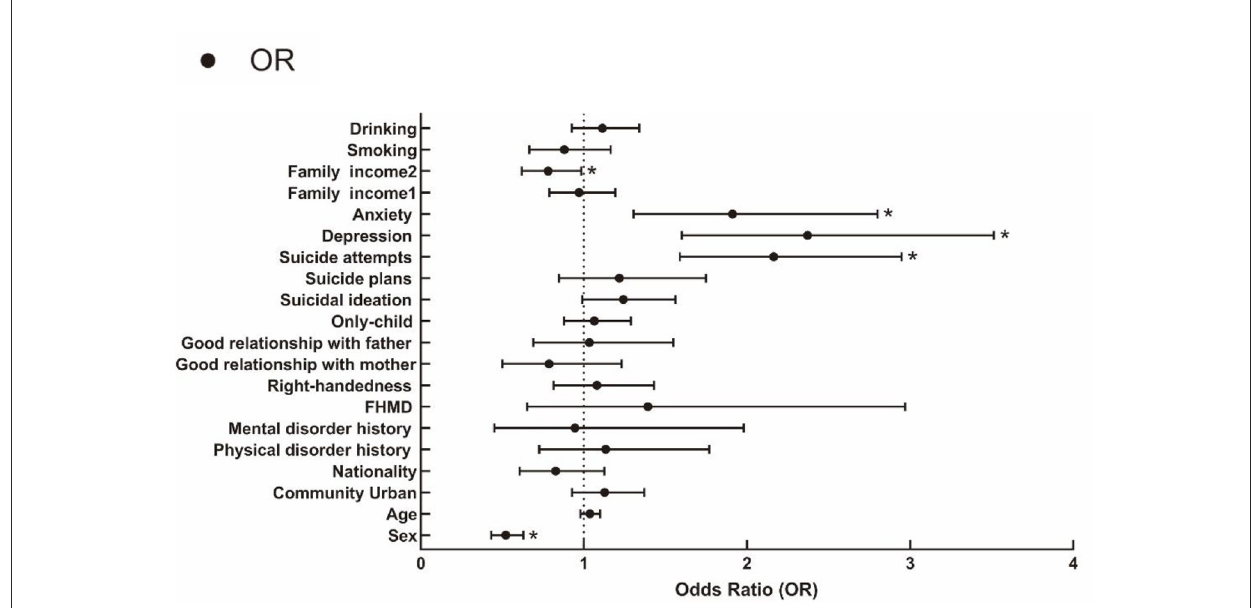
FIGURE1 Adjusted odds ratio (OR) of variables associated with cyberbullying using binary logistic regression analysis. OR, odds ratio; FHMD, family history of mental disorders; Family income 1, family income 30,000 ∼ 70,000 yuan per year; Family income 2, family income over 70,000 yuan per year.